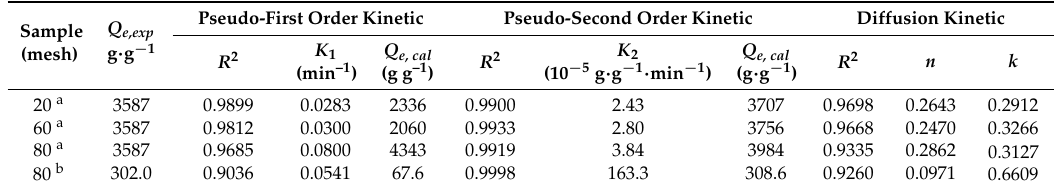
Table 3. Kinetic parameters for swelling behavior of SD-PAA in distilled water and 150 mM NaCl solution. Sample